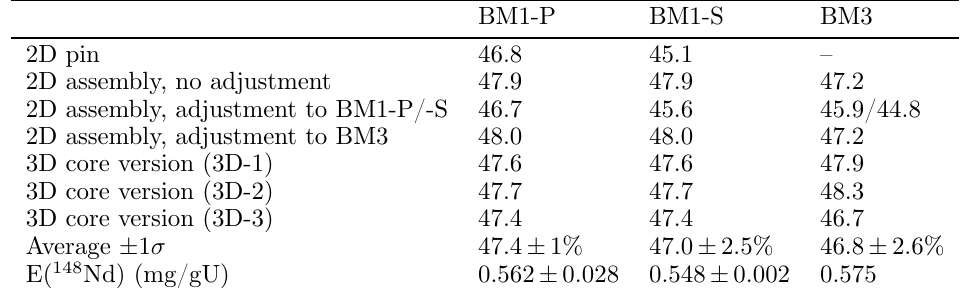
Table 1. Comparison of calculated sample burnup values, following different methods. Values are provided in MWd/kgHM.